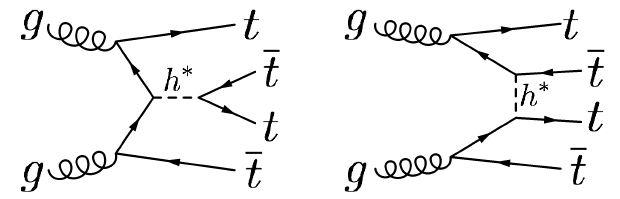
Figure 4 . A sample of Feynman diagrams with an o(cid:11)-shell Higgs contribution to four-top produc- tion at the LHC ( pp ! t (cid:22) tt (cid:22) t